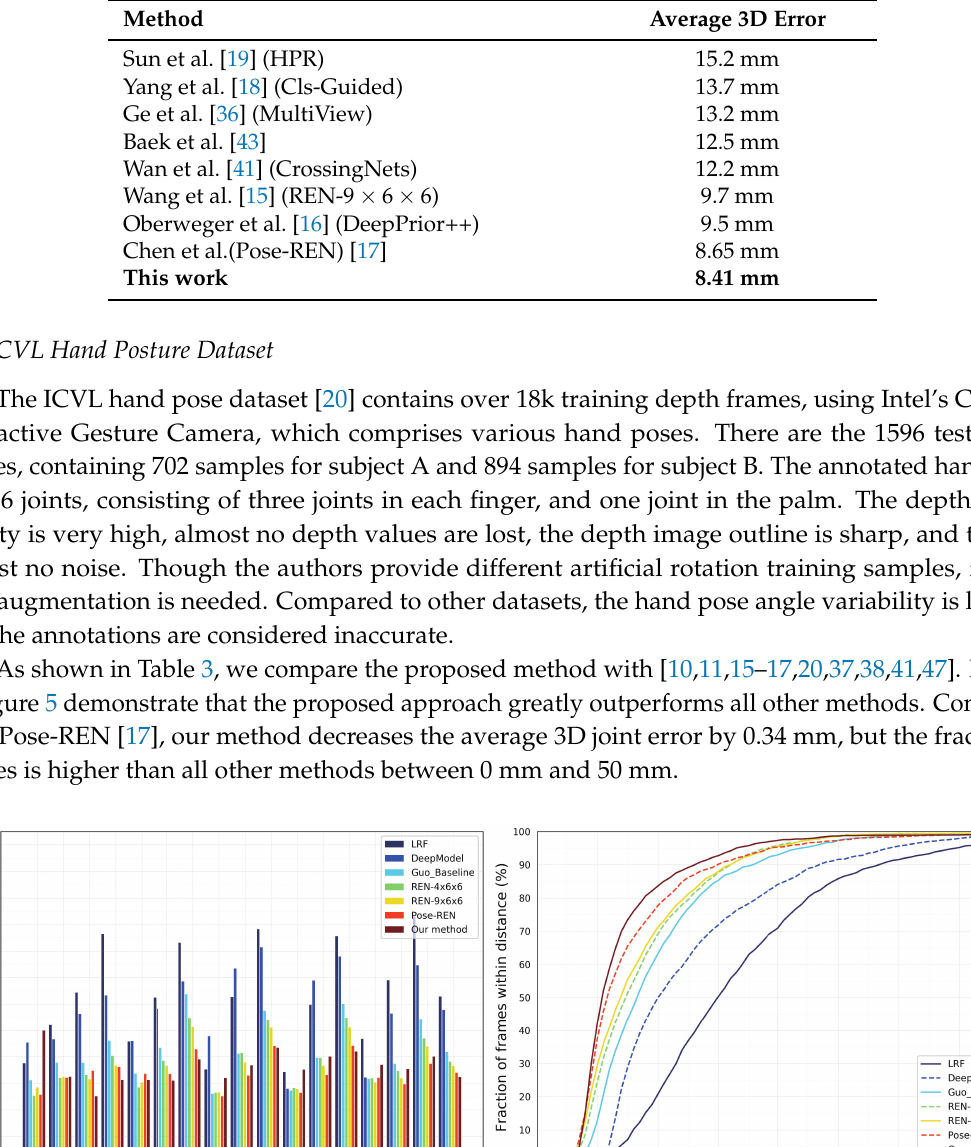
Table 2. On the MSRA dataset [19], we compare the proposed approach to the state of the art. It proves that our method has better results by the evaluation metric of the average 3D joint error in the table below.